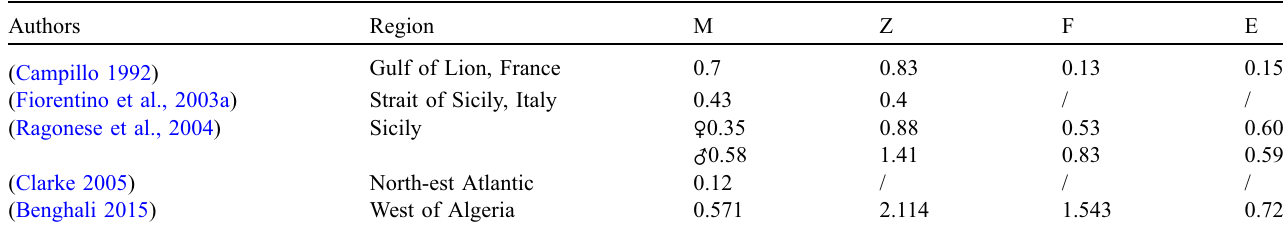
Table 6. Biogeographic comparison of mortalities and exploitation rates of P. blennoides . Natural mortality (M), total mortality (Z), fi shing mortality (F), and exploitation rate